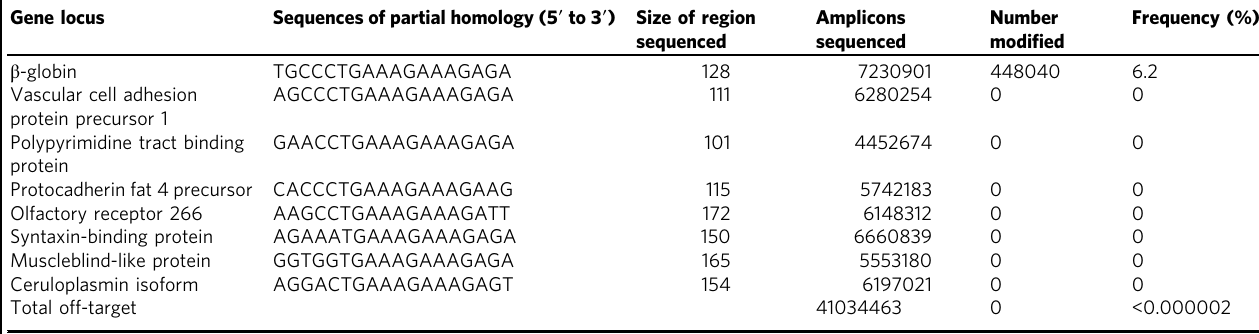
Table 1 Deep sequencing analysis of targeted gene editing versus off-target effects in bone marrow cells 15 weeks after a single in utero γ tcPNA/DNA nanoparticle (NP) treatment Gene locus Sequences of partial homology (5 ′ to 3 ′ ) Size of region